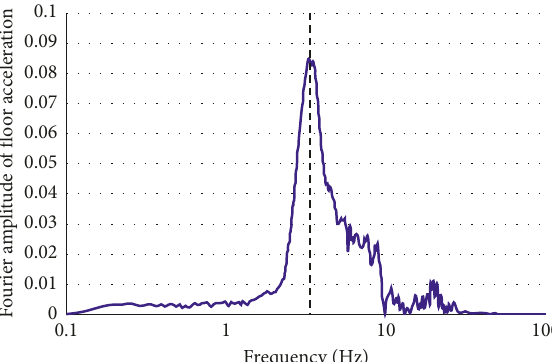
Figure 7: Fourier spectra of floor acceleration response at roof level for free vibration of undamaged bare frame structure. The values are those for the reduced scale test